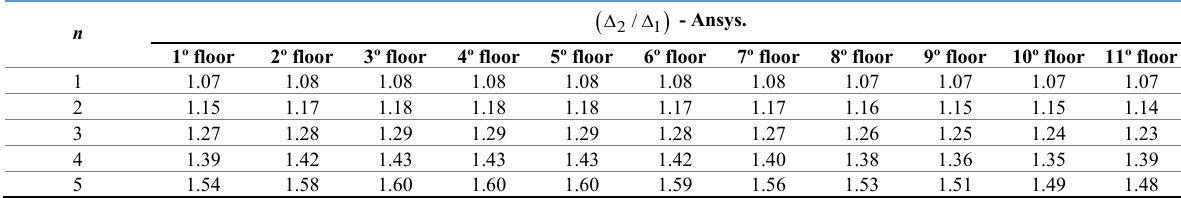
Table 6 - Ratio of initial to final displacements ( ) 2 1 / ∆ ∆ obtained with Ansys. Source: Authors (2020).